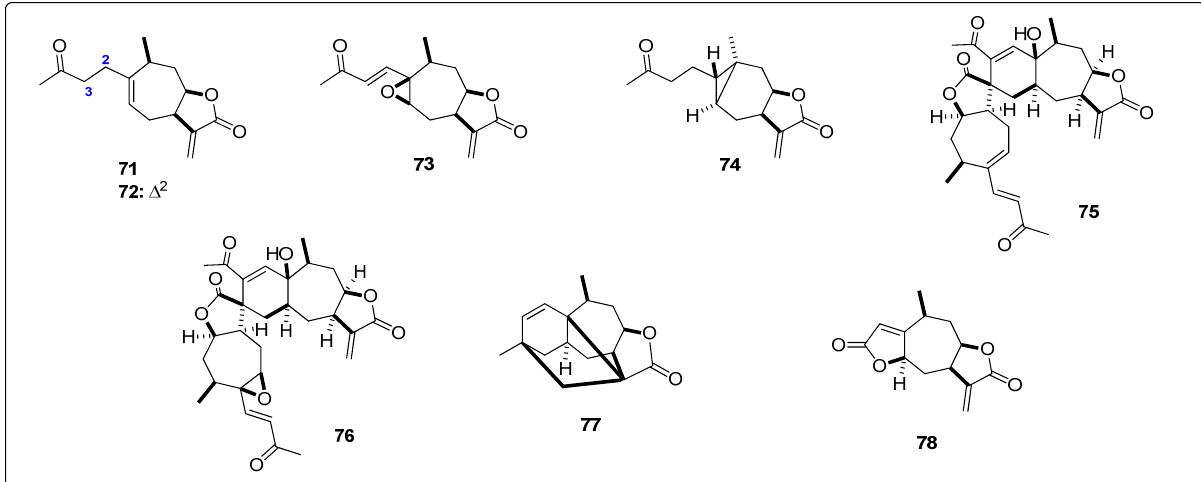
Figure 6. Structures of the tested xanthanolide sesquiterpenes [27].